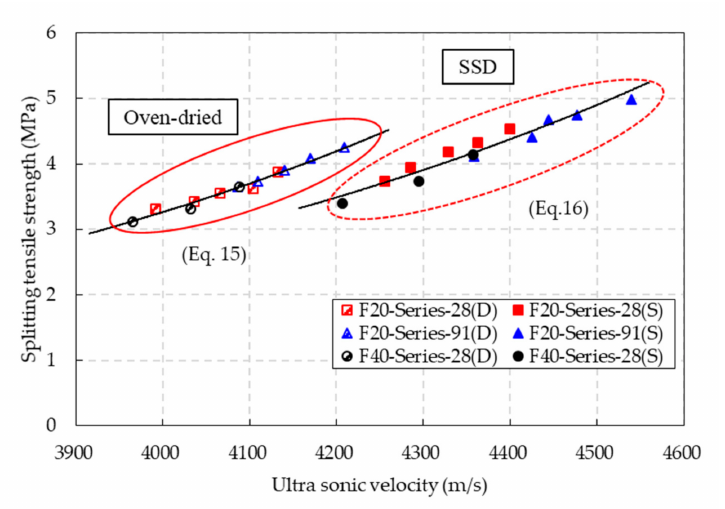
Figure 16. Relationships between the ultrasonic velocity and splitting tensile strength under SSD and oven-dried